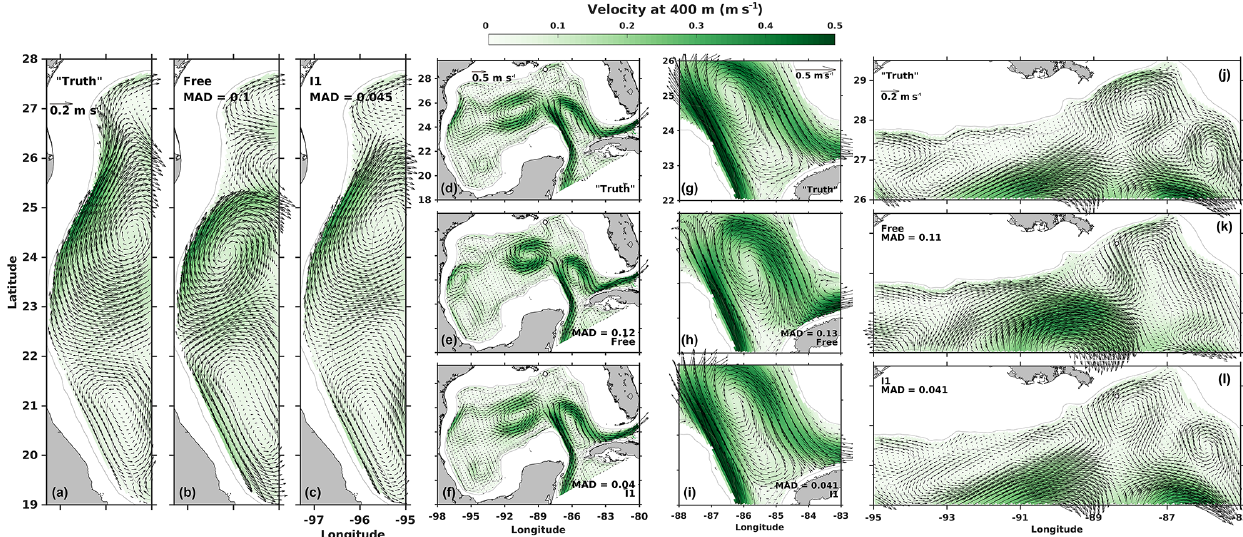
Figure 10. August mean velocity at 400m in the (a, d, g, j) “truth”, (b, e, h, k) free, and (c, f, i, l) I1 run in identical twin experiments. Panels in the first, third, and fourth columns are zoomed into the western shelf, central gulf, and northern shelf, respectively. The white dot denotes the location of the DwH oil rig, and gray contours mark the bathymetric depths of 300, 1000, 2000, and 3000m,